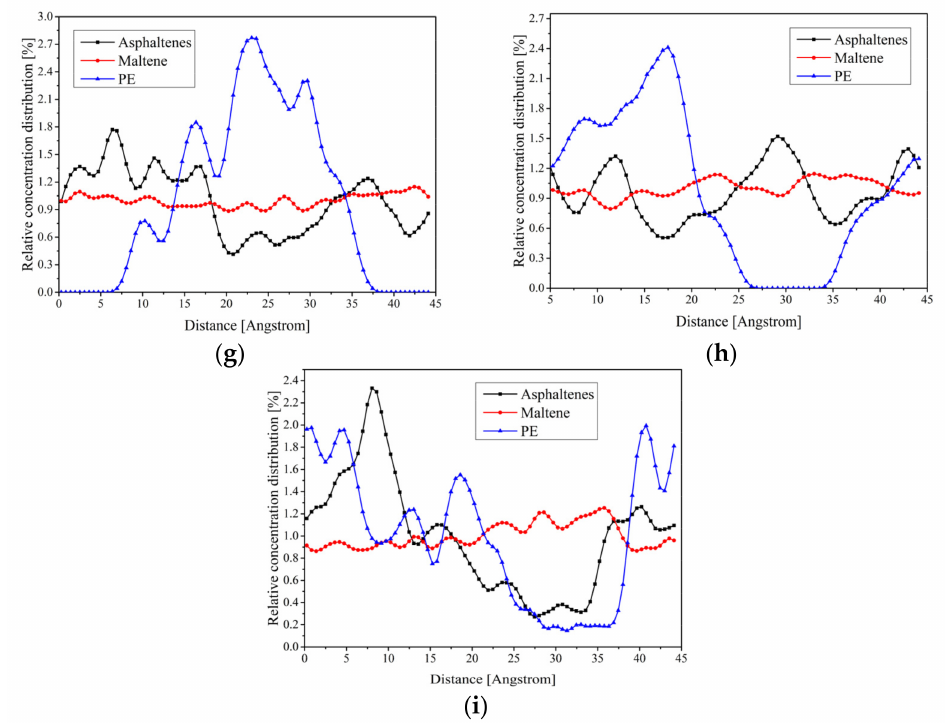
Figure 13. Concentration distribution of virgin asphalt, RPE-modified asphalt and CNT/RPE- modified asphalt in X, Y and Z directions. ( a ) Virgin asphalt-X, ( b ) Virgin asphalt-Y, ( c ) Virgin asphalt-Z, ( d ) RPE-modified asphalt-X, ( e ) RPE-modified asphalt-X, ( f ) RPE-modified asphalt-X, ( g ) CNT/RPE-modified asphalt-X, ( h ) CNT/RPE-modified asphalt-Y, ( i ) CNT/RPE-modified